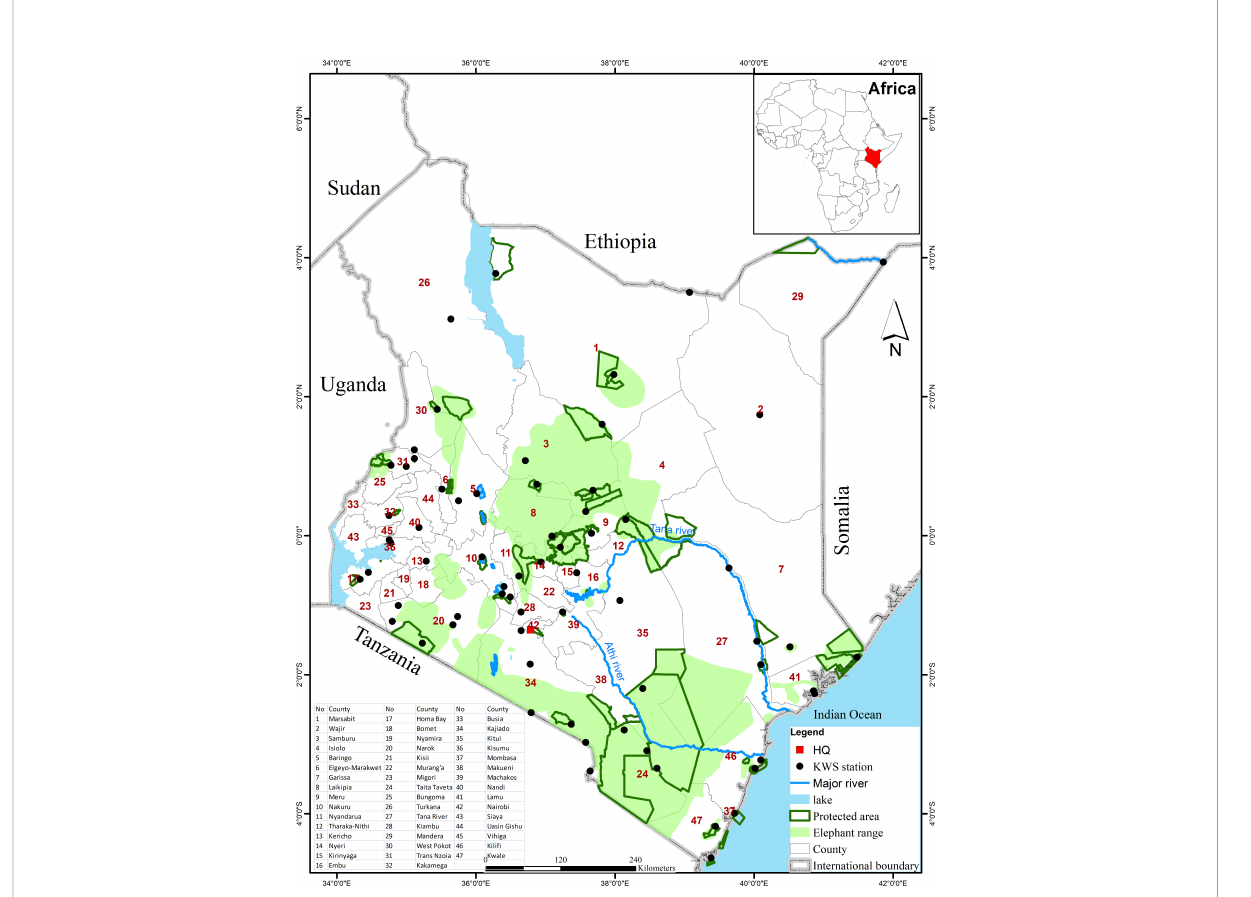
FIGURE 1 Map of Kenya showing protected areas and the elephant range superimposed on the 47 administrative counties. A national network of the KWS stations collects and transmits elephant mortality data to the KWS Command Center at the Nairobi Headquarters (HQ in the